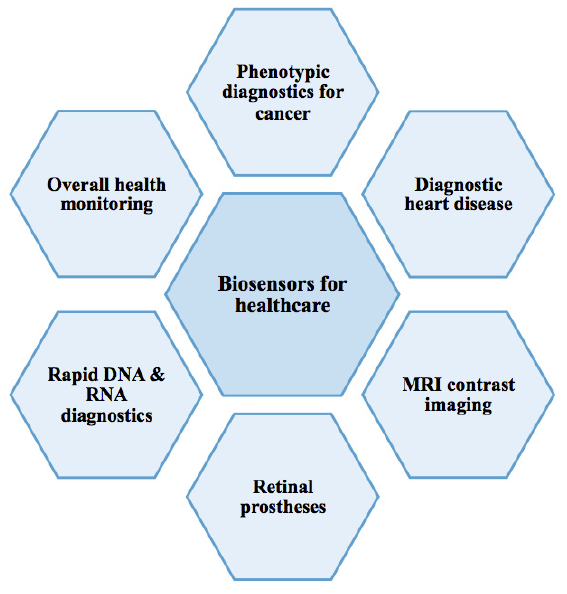
Figure 4. Biosensors’ typical functions in healthcare services.